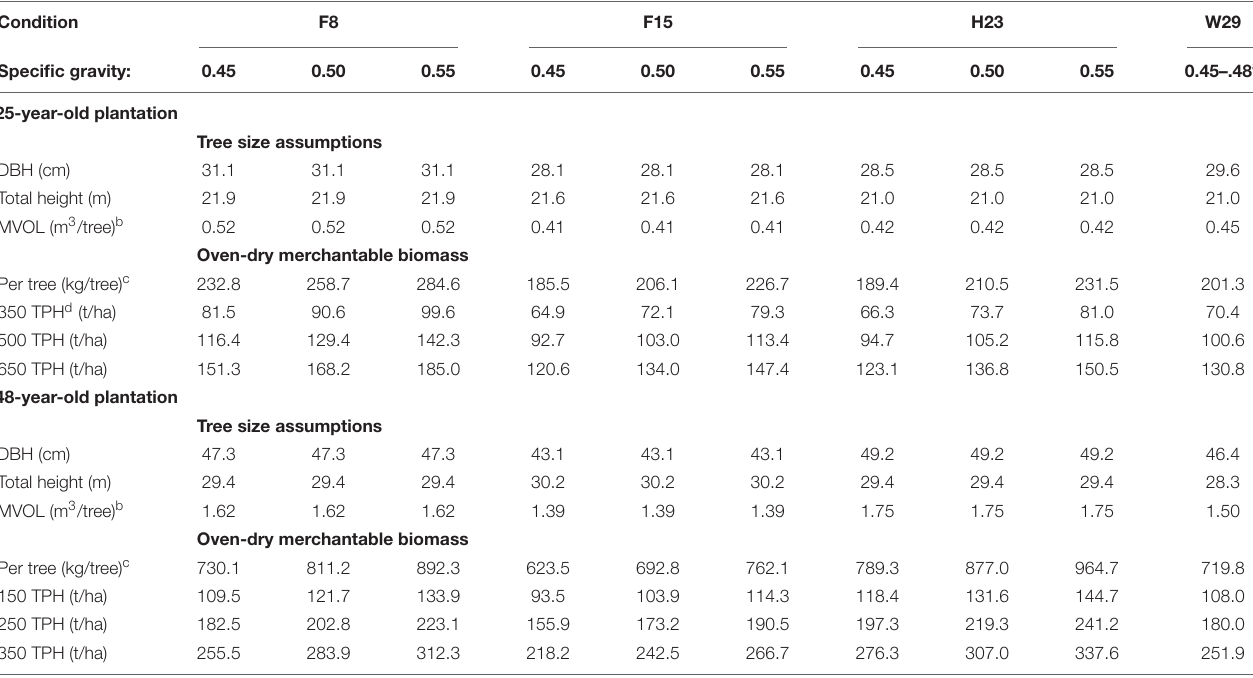
TABLE 7 | Oven-dry merchantable biomass predictions (using different levels of wood specific gravity) of loblolly pine plantations at 25 and 48 years after planting using the top-performing family identified at 3, 25, and 48 years of age (F15, F8, and H23, respectively), compared with the Crossett woods-run family (W29) as the standard. Condition F8 F15 H23